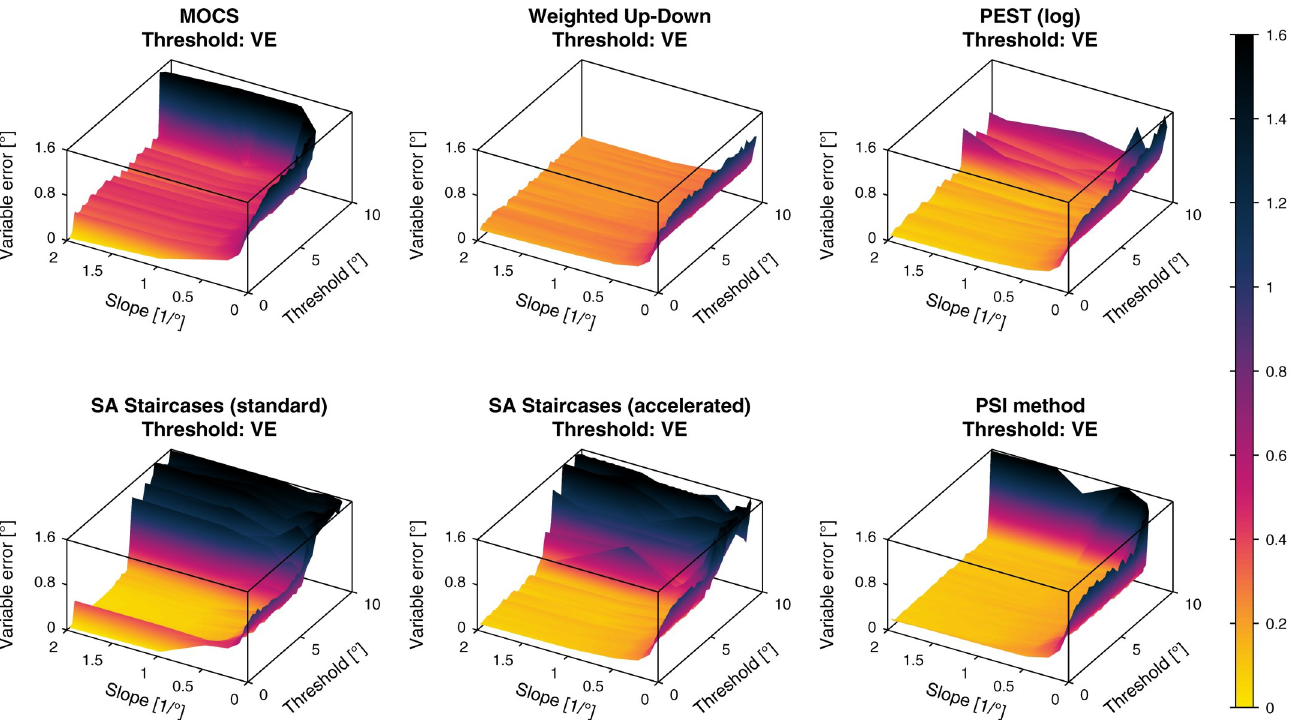
Fig 7. Variable errors of threshold estimates. Variable errors ( VE ) of the threshold estimates for the six different simulated sampling procedures. The color bar indicated the VE values in (˚).